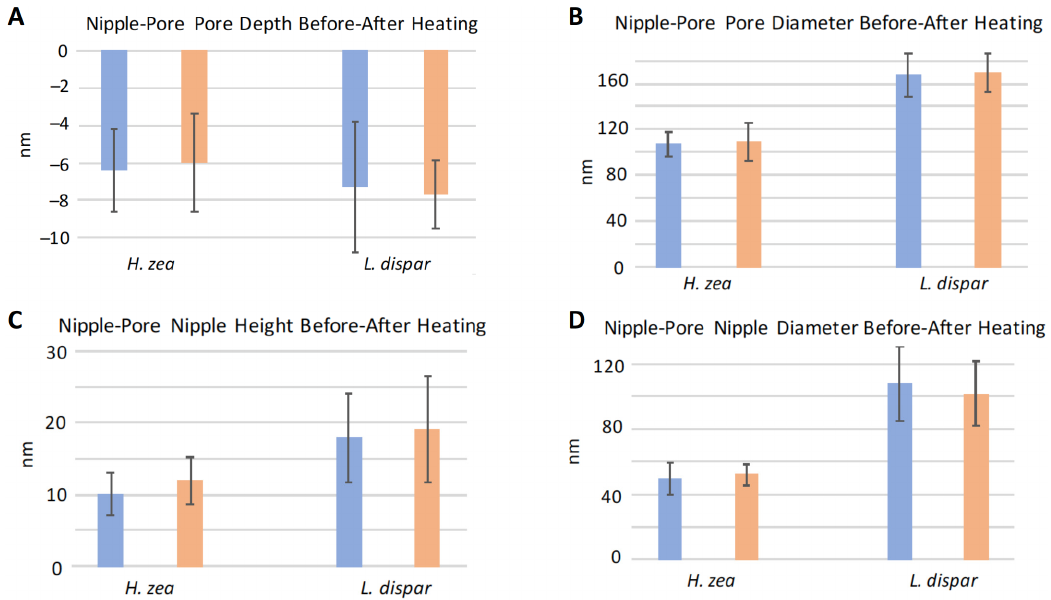
Figure 11. Effect of heating on mean heights, depths and diameters of nipple-pore pores and nipple- pore nipples on Helicoverpa zea and Lymantria dispar trichoid sensilla. Blue histogram bars indicate measurements taken on sensilla at 23 °C. Orange bars indicate measurements taken on the same sensilla after heating to 50 °C. ( A , B ) N = 23 nipple-pore pores measured for H. zea and N = 10 for L. dispar . ( C , D ) N = 23 nipple-pore nipples measured for H. zea and N = 10 for L. dispar . Error bars denote standard deviation.